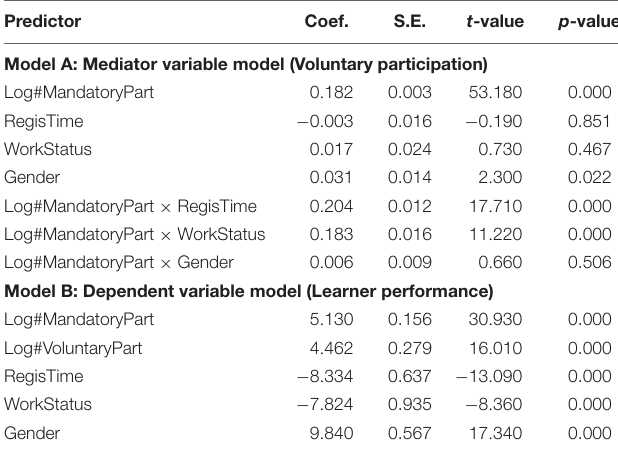
TABLE 6 | Moderated mediation model ( n = 27,767) (single moderation).